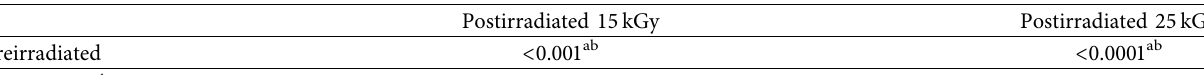
Table 8: Comparison of TGF- β and bFGF mean percentage decrease between the preirradiated and postirradiated 25kGy freeze-dried amnion membrane (FD-AM) and amnion sponge.